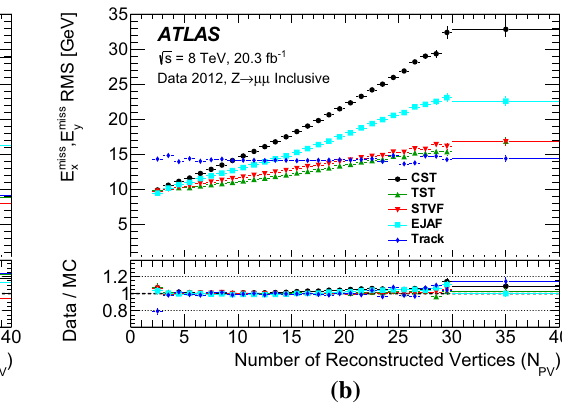
in data. The insets at the bottom of the figures show the ratios of the data to the MC predictions algo- T